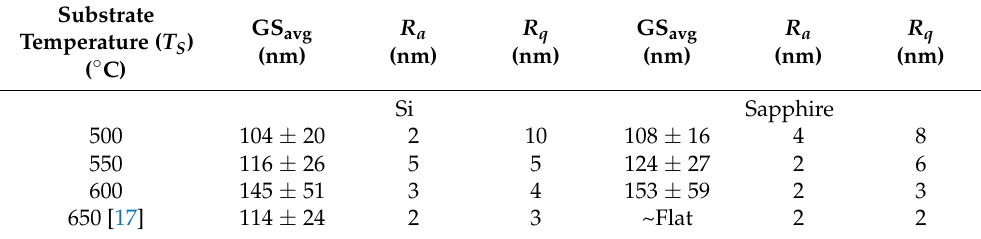
Figure 4. Surface profile images of VO 2 thin films deposited on Si and sapphire substrates at ( a ) 500 °C, ( b ) 550 °C, ( c ) 600 °C and ( d ) 650 °C [17]. The roughness of the surface is indicated by color mapping, where the maximum (peak), median and minimum (depth) points on the surface are indicated in red, green and blue, respectively. The scale bars are used as a measure of the peaks and depths on the surface of the films. Table 2. Average grain size (GS avg ), average ( R a ) and root-mean square ( R q ) roughness of VO 2 thin films prepared at various substrate temperatures ( T S